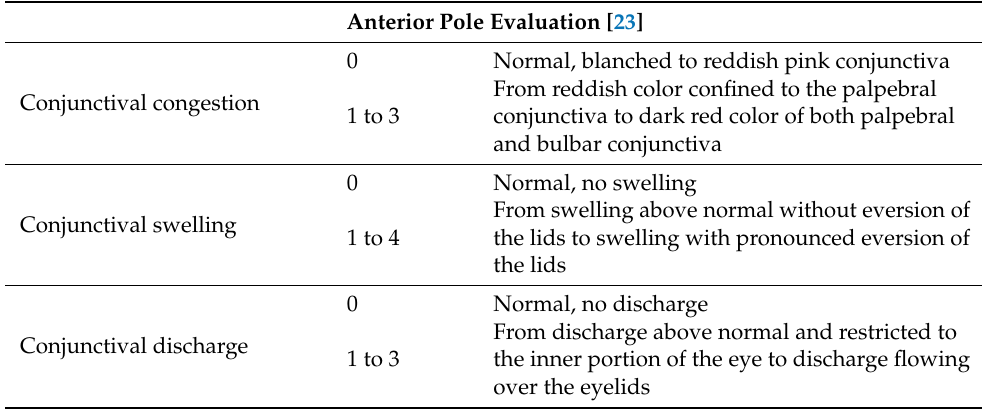
Table 1. Ophthalmic evaluation using scored